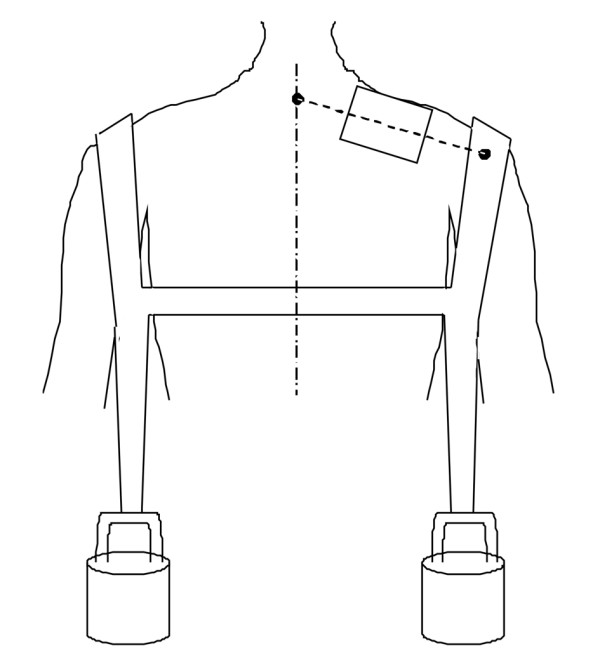
Experimental setup. Posterior view of a subject, electromyographical electrode device (rectangle), and weight harness. The centre of the electrode-device was placed in the middle of the line between processus spinosus of the C7 vertebra and the lateral edge of acromion. The harness was used to attach weights symmetrically on the shoulders. Subjects performed isometric shoulder elevation such that their shoulders were held in the horizontal plane.